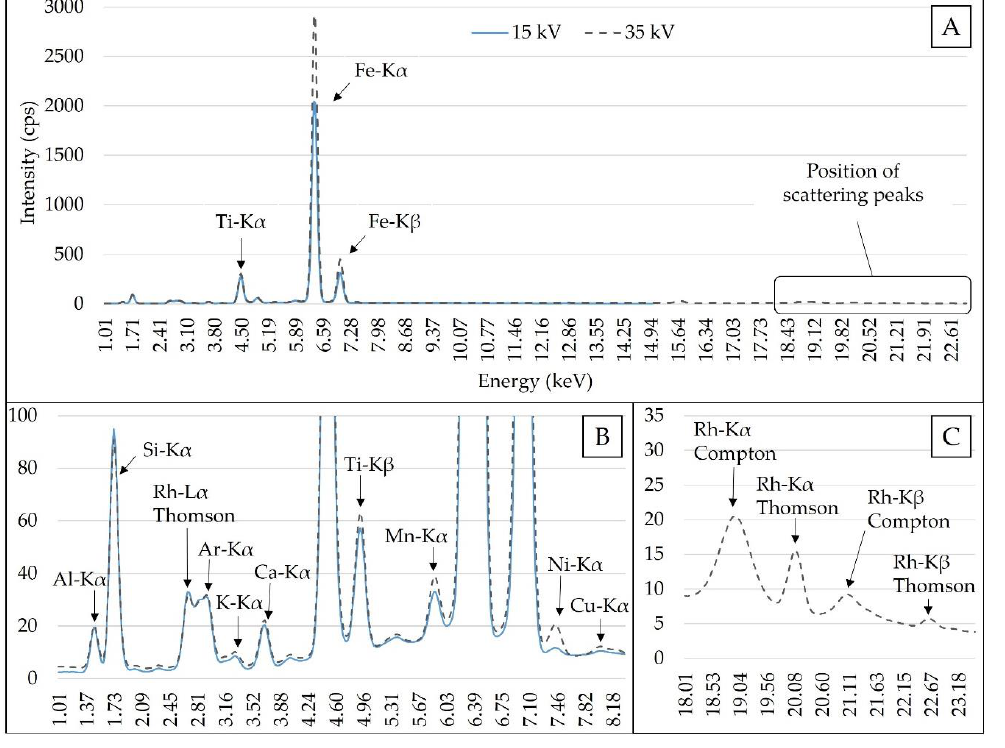
Figure 2. Mean of X-ray fluorescence (XRF) spectra obtained with an X-ray tube set at 15 and 35 kV ( A ). Snapshot of the emission lines from 1.01 to 8.34 keV, which presented lower fluorescence emission in relation to the Kα emission lines of iron (Fe) and titanium (Ti) ( B ). Snapshot of scattering peaks ( C ). Counts of photons per second was abbreviated as cps.